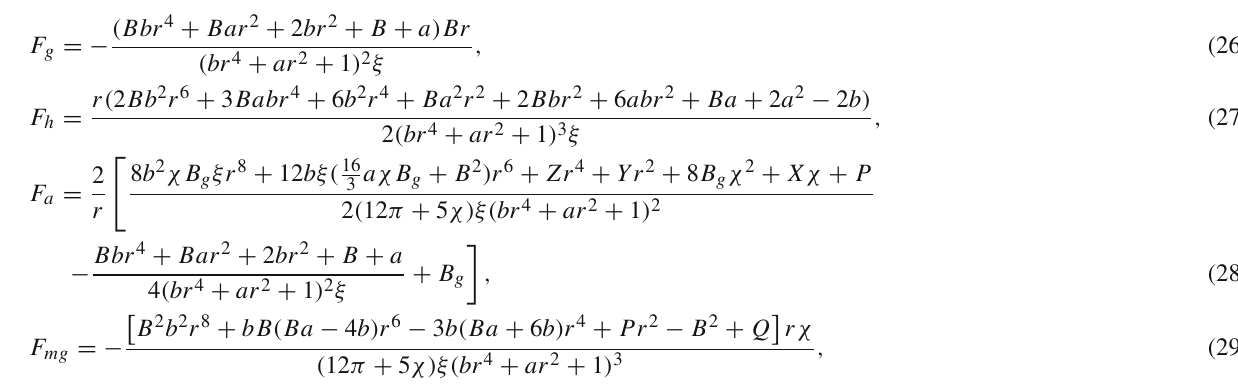
Fig. 5 Variation of v 2 rs and v 2 ts (upper panel), | v 2 rs − v 2 ts | (lower panel) w.r.t. the radial coordinate r for the strange star candidate PSRJ 1614– 2230 zero, i.e., F g + F h + F a + F mg = 0, which implies that our system is completely stable.